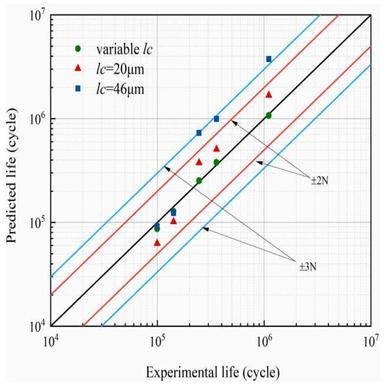
Predicted versus experimental fretting fatigue lives.